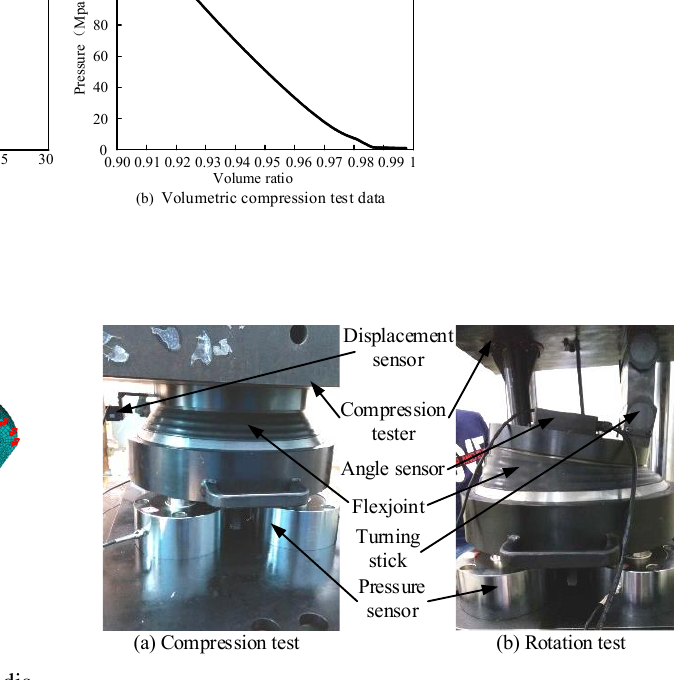
Figure 10. The compression and rotation test